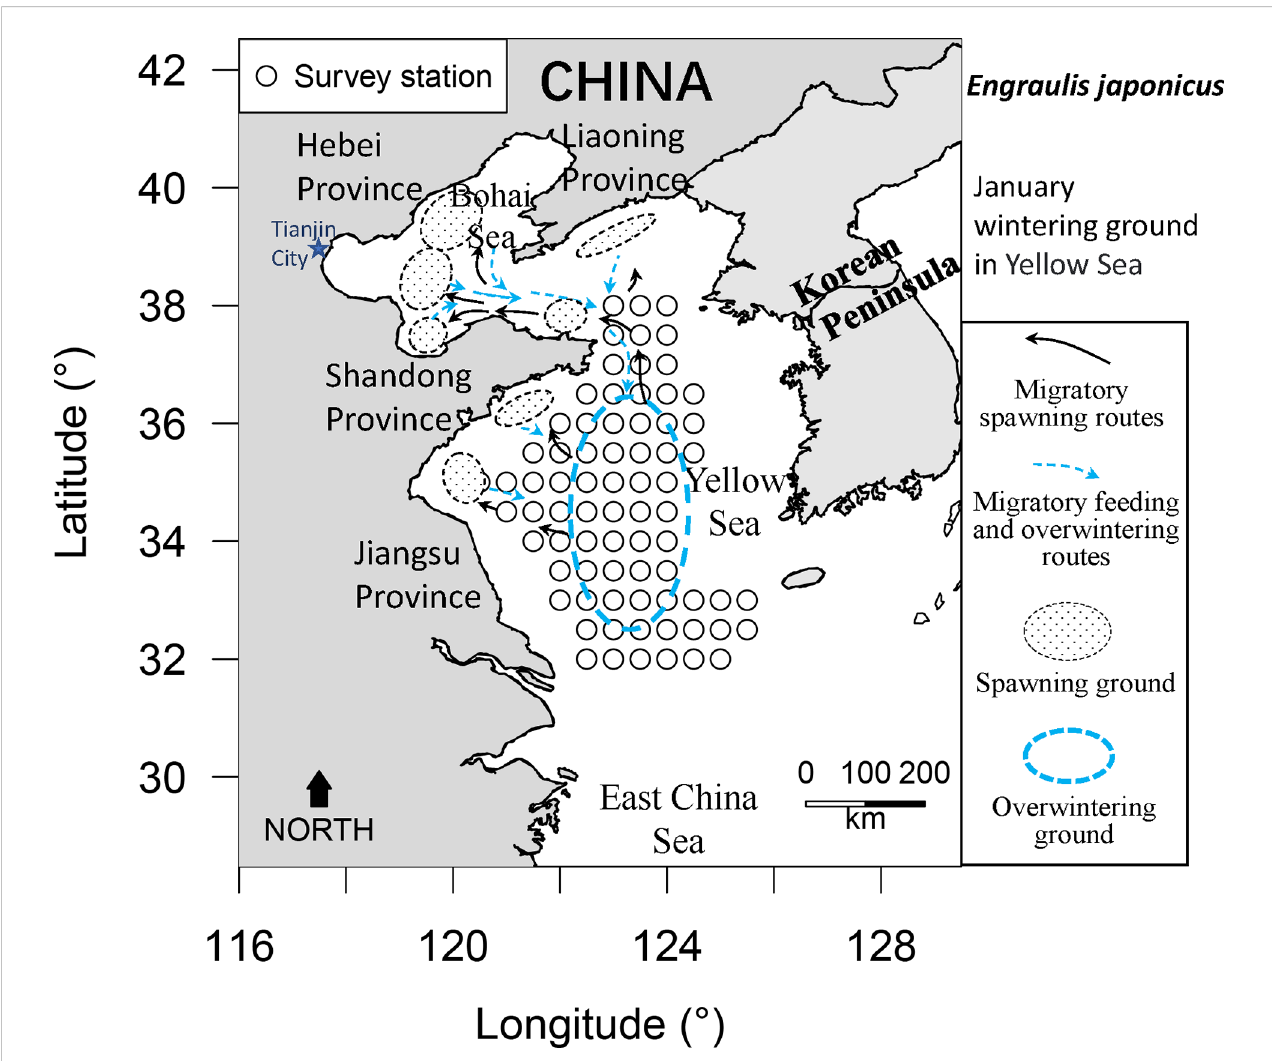
FIGURE 1 Survey Station and migration distribution of Japanese anchovy in the Yellow Sea Large Marine